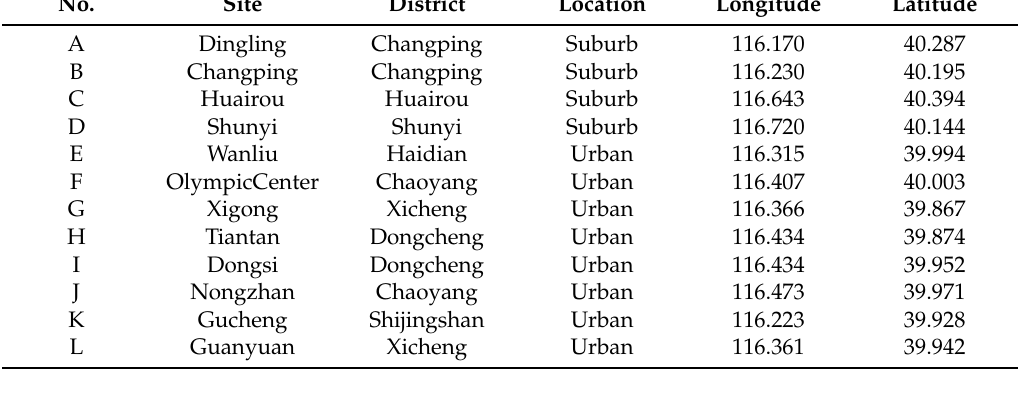
Table 1. Summary information of the 12 Beijing PM 2.5 sites.